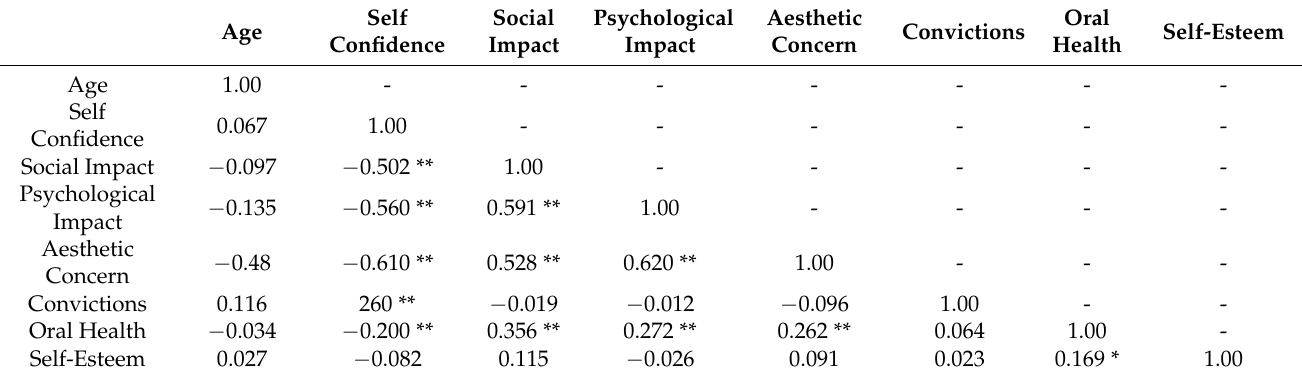
Table 3. Nonparametric correlations [* p < 0.05 level (2-tailed), ** p < 0.01 level (2-tailed)].